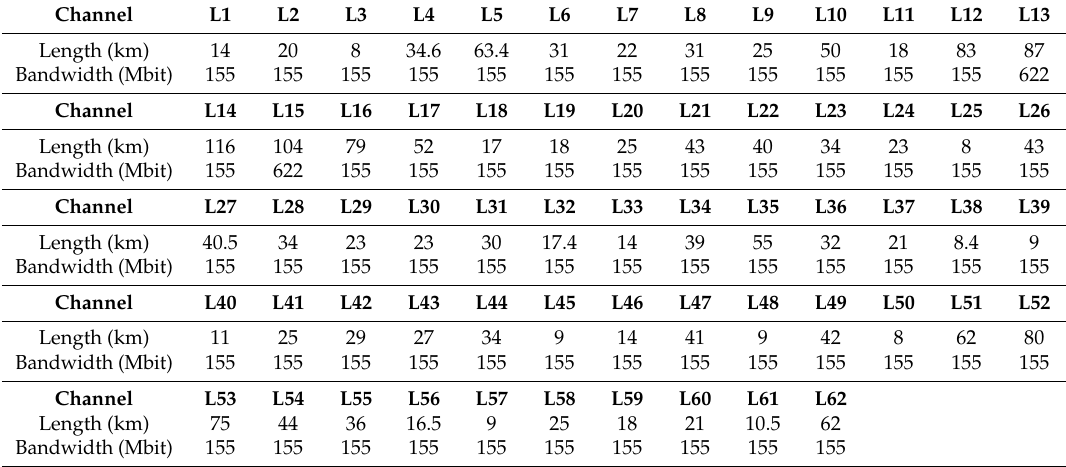
Table A2. The communication system parameters of the 220 kV grid in the eastern region of Hubei,